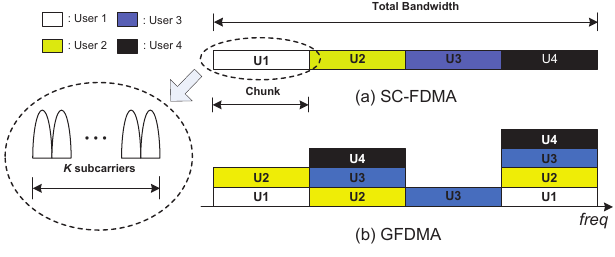
Figure 1. Frequency domain description for each time slot in SC-FDMA ( a ) and SC-GFDMA ( b ) with localized subcarrier mapping ( M = 4, U =